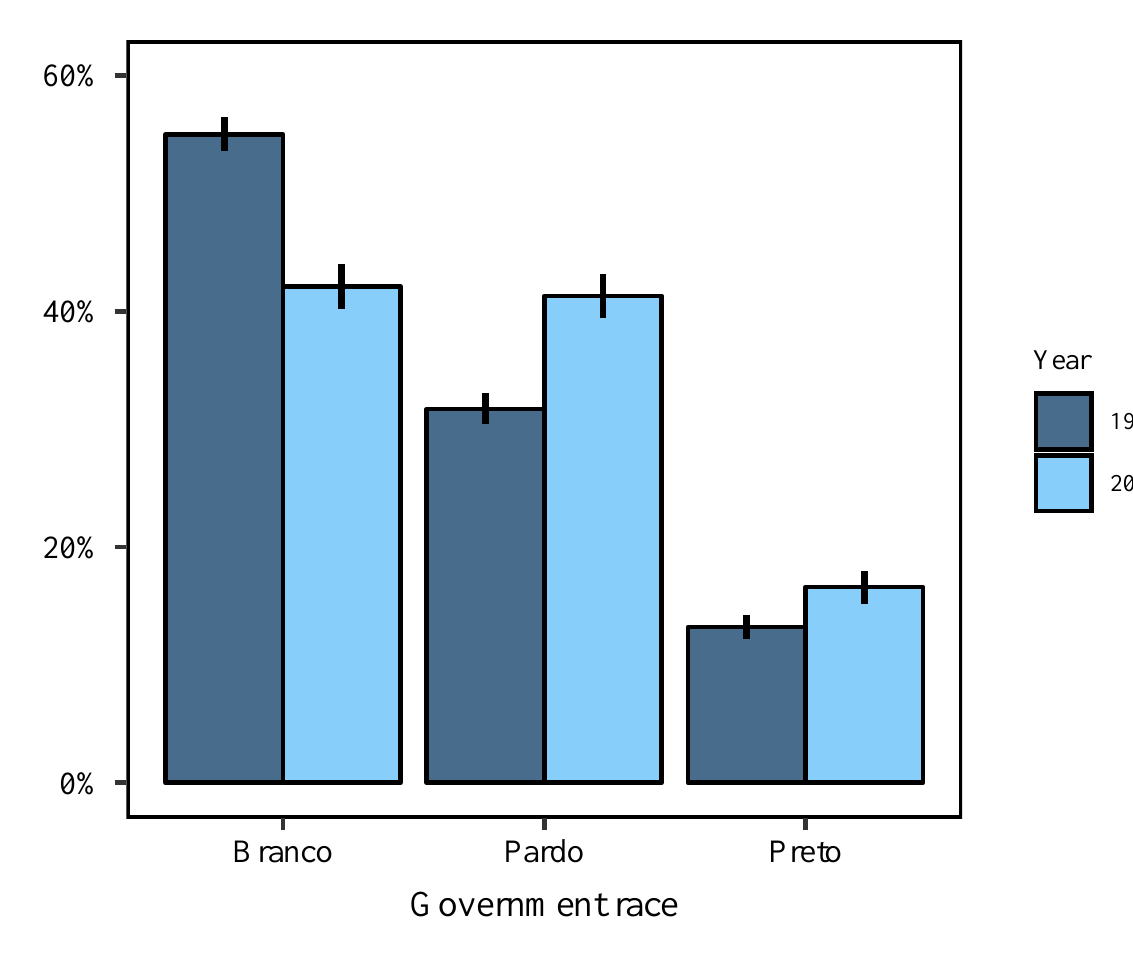
Figure 1: Racial composition by government classification, 1995 and